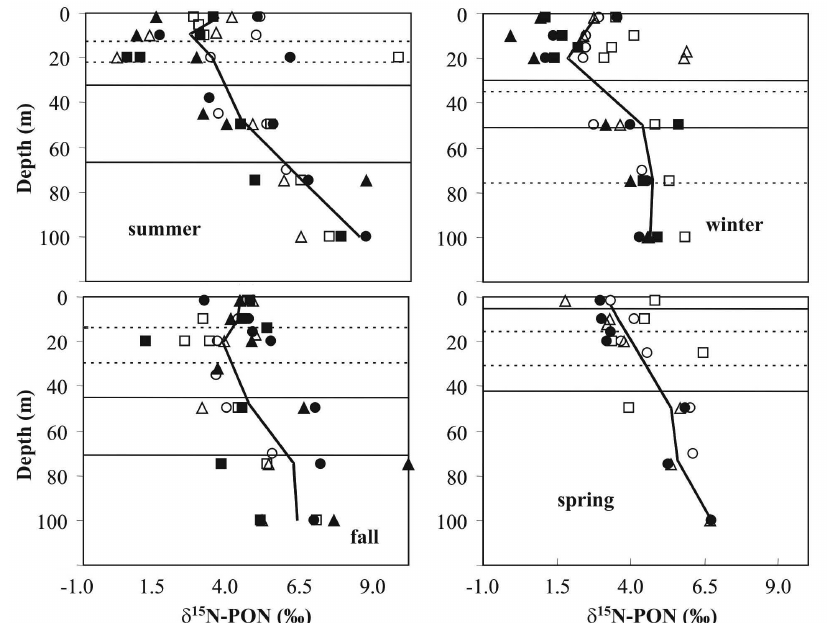
Fig . 4. – The d 15 N (‰) of particulate organic nitrogen at the sampling stations during the four seasonal surveys (station 1: open circles; sta- tion 2: open squares; station 3: open triangles; station 4: closed circles; station 5: closed squares; station 6: closed triangles). The solid lines represent the averaged seasonal profiles. The horizontal solid and dotted lines indicate the ranges of variation of the 37.5 isohaline position and the lower limit of the mixed layer respectively.